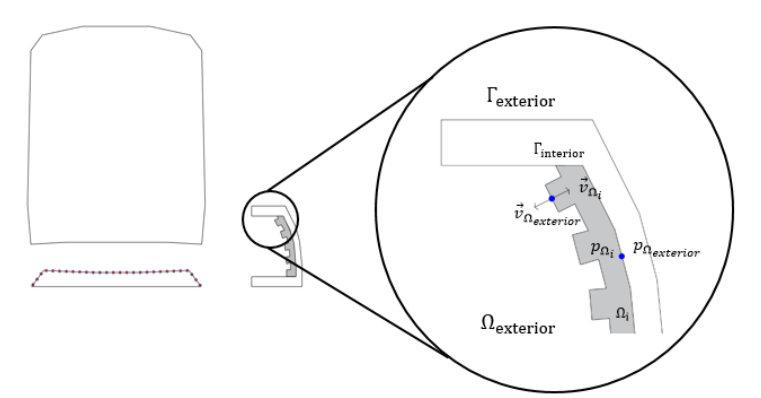
Figure 9. Representation of the coupled interior/exterior